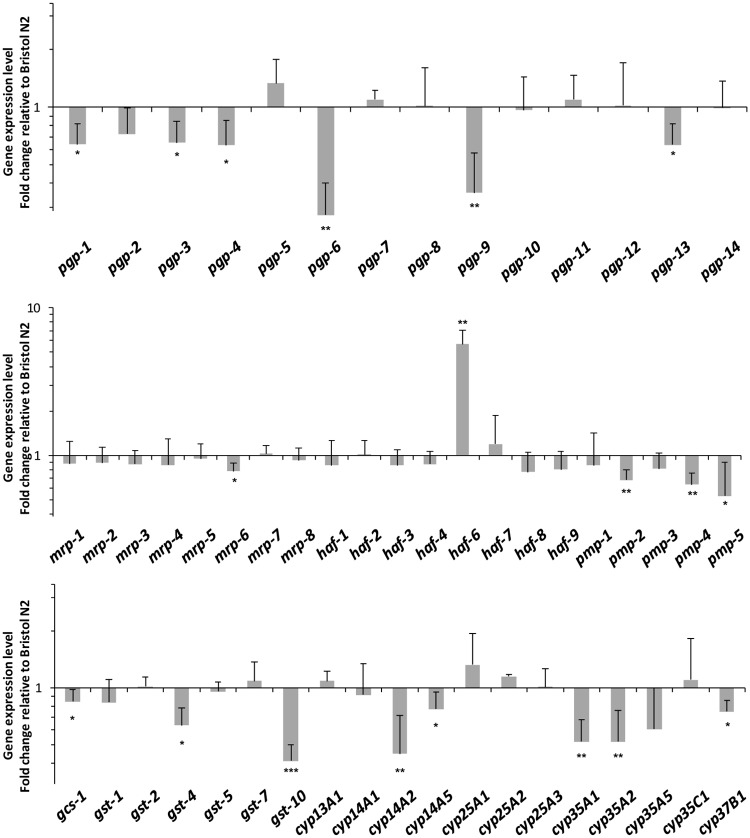
Transcriptional profile of genes associated with xenobiotic metabolism and transport in nhr-8(ok186) C. elegans relative to wild-type worms.Changes in levels of mRNAs encoding ABC transporters and several phase II detoxification enzymes and cytochromes P450, normalized with respect to cdc-42 mRNA levels, were determined by real-time qPCR. Gene expression levels are expressed as -fold change relative to wild-type Bristol N2 and are reported as the mean ± S.D. of four to five independent experiments. * p<0.05; ** p<0.01; *** p<0.001 vs. wild-type Bristol N2. Student’s t-test between wild-type and nhr-8 mutant for each gene.